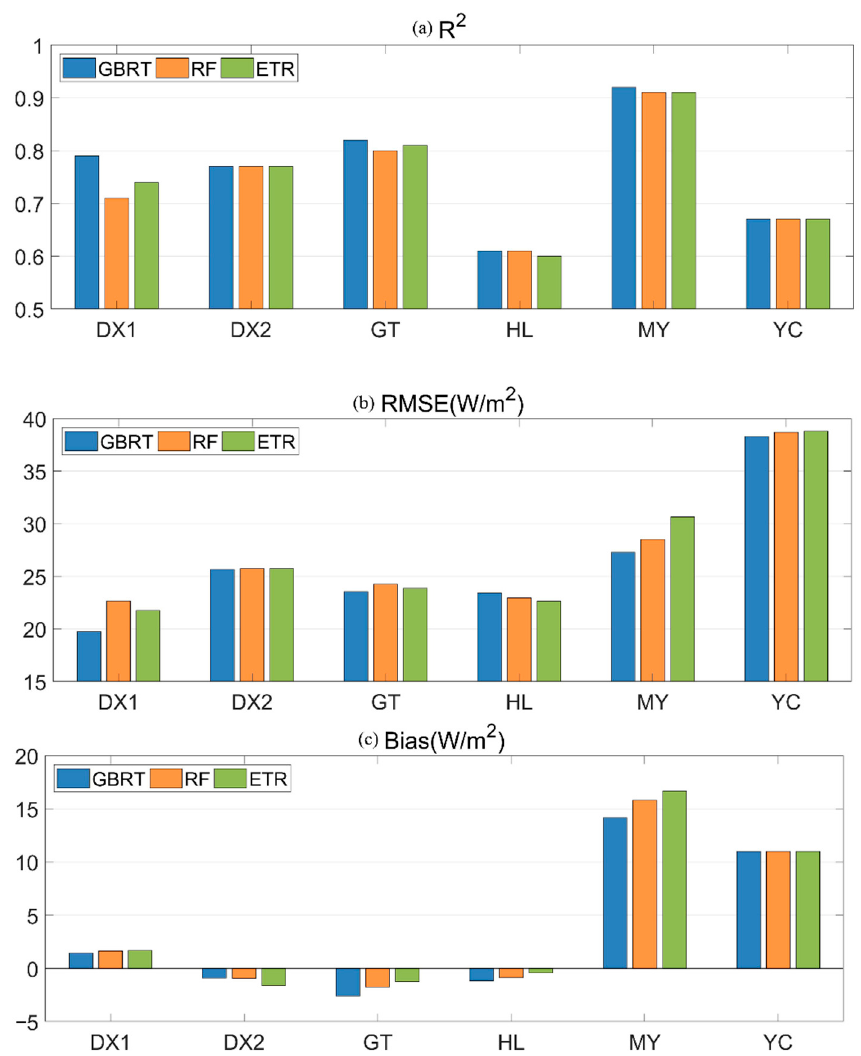
Figure 4. The performance indices result of the testing data of the first cross-validation experiment of each site for the three machine-learning algorithms. ( a ): R2; ( b ): RMSE; ( c ): Bias.